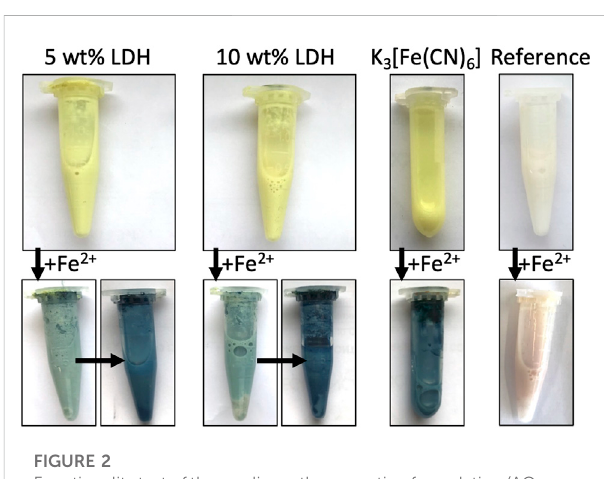
FIGURE 2 Functionalitytestoftheacrylicurethanecoatingformulation(AQ CC 80) with 5 and 10 wt% of Mg-Al/[Fe(CN) 6 ] LDH nanoadditive compared to the reference sample and formulation with 1.3 wt% of K 3 [Fe(CN) 6 ]